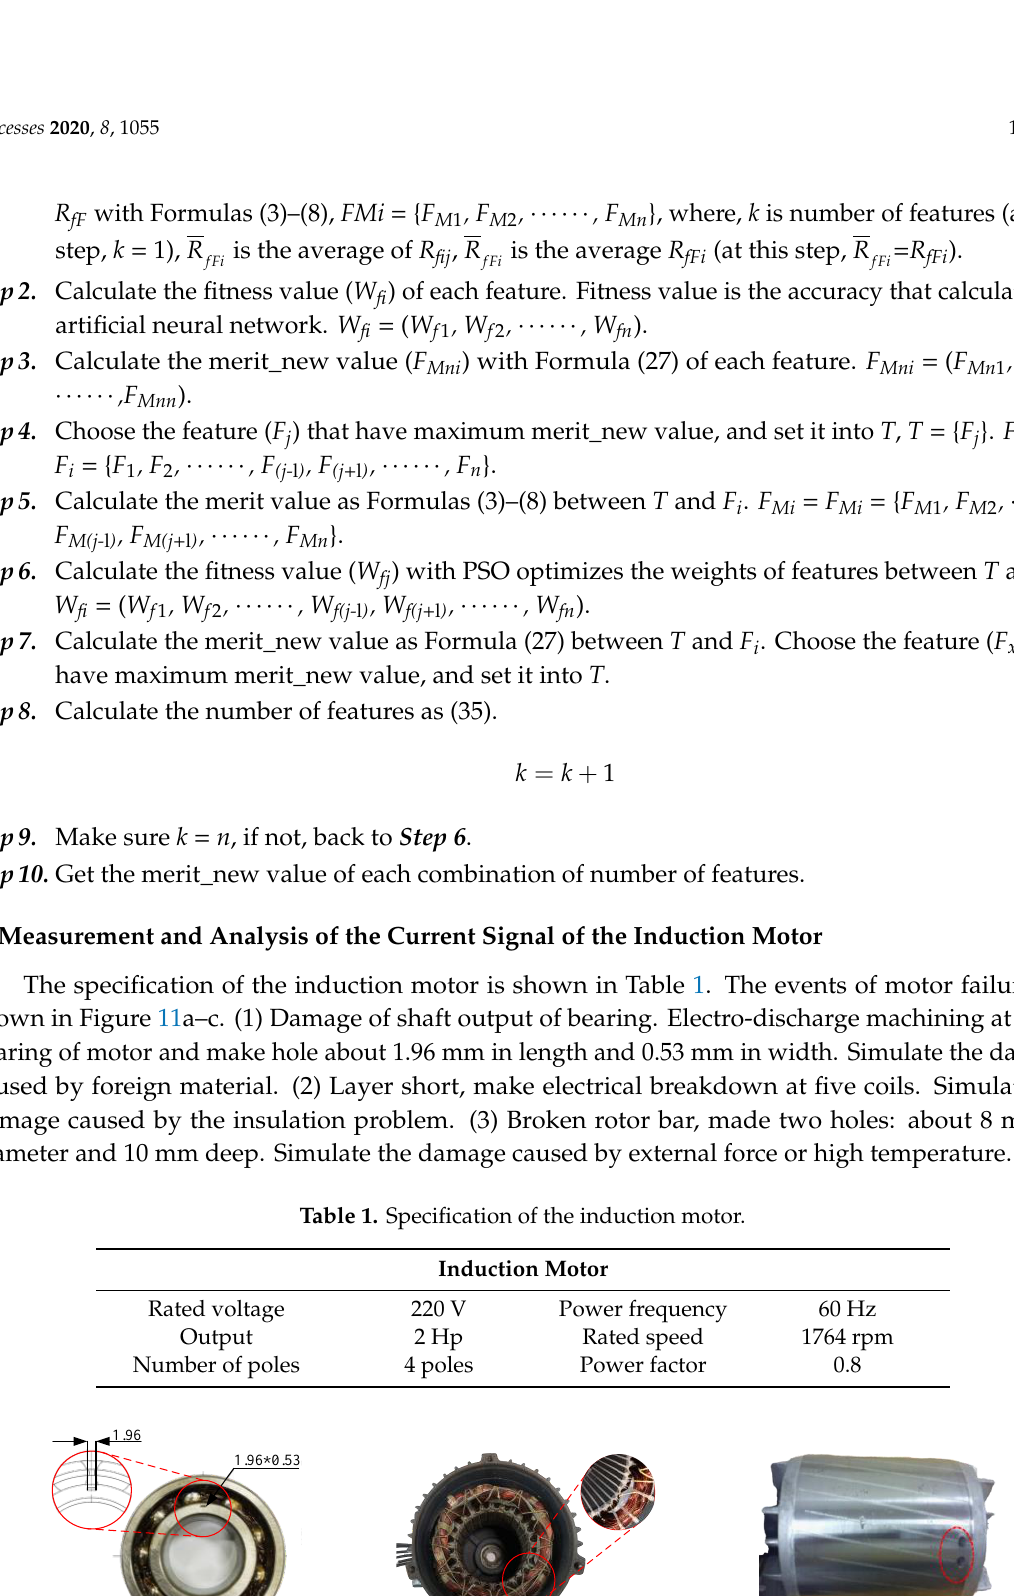
Matlab Control panel Figure 12. Equipment layout to capture the current signal of induction motor. Step 1.